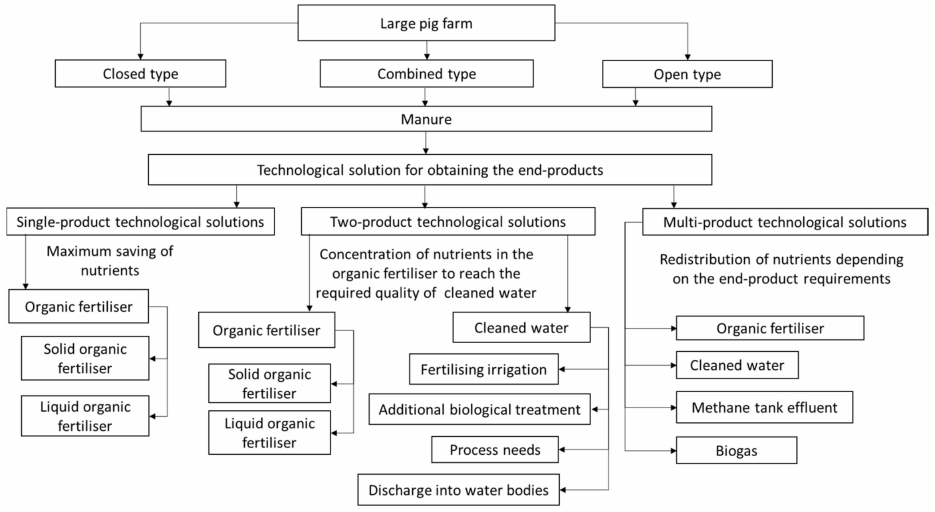
Figure 2. Methodical approach to obtaining quantity and quality of end-products depending on applied technological